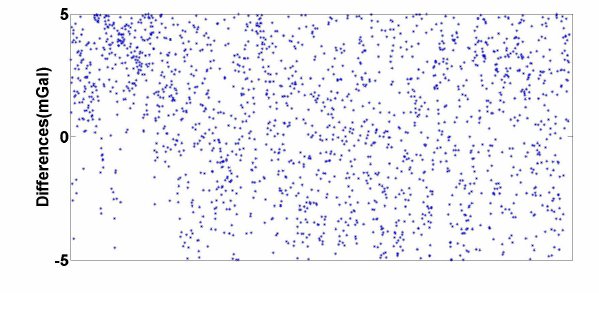
Fig. 2. Scattered diagram of differences between SMLS approxi- mated values and those from shipborne gravimetry